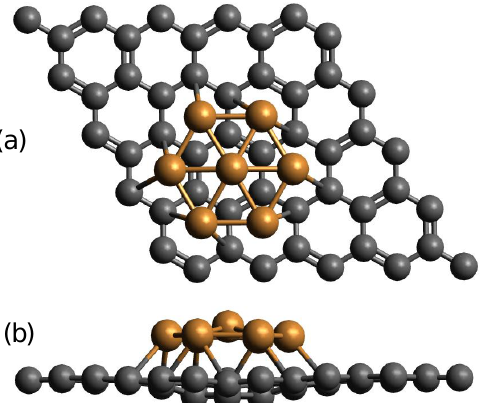
Figure 1. Top ( a ) and aside ( b ) views of equilibrium structure of six-faceted Cu nanopyramid deposited on graphene monolayer. Grey balls stand for carbon atoms and orange for copper.